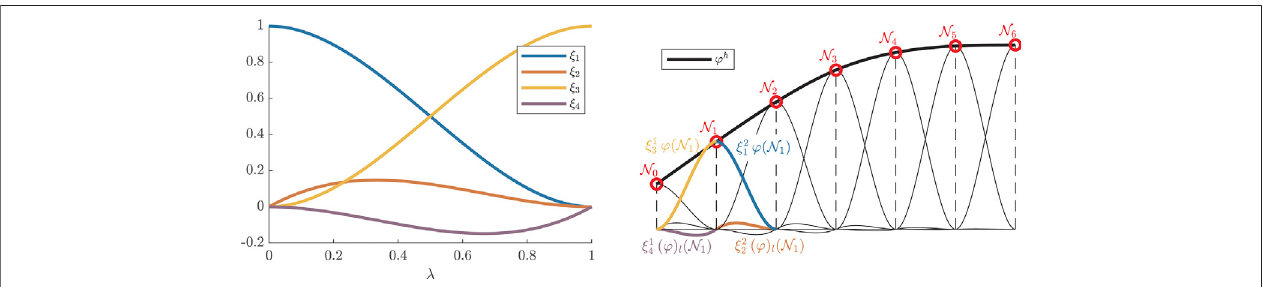
FIGURE 2 | FEMnodesandelements.Thelocalbasisfunctions( Eq.29 )ofaunitelementareshownontheleft.Therightplotshowstheassemblyof N (cid:2) 6 elementstoan approximate curve tangent pro fi le φ h . It further illustrates the role of the local element basis functions ξ e 1 .. 4 scaled by function values φ and ( φ ) l at the node locations N 0 .. 6